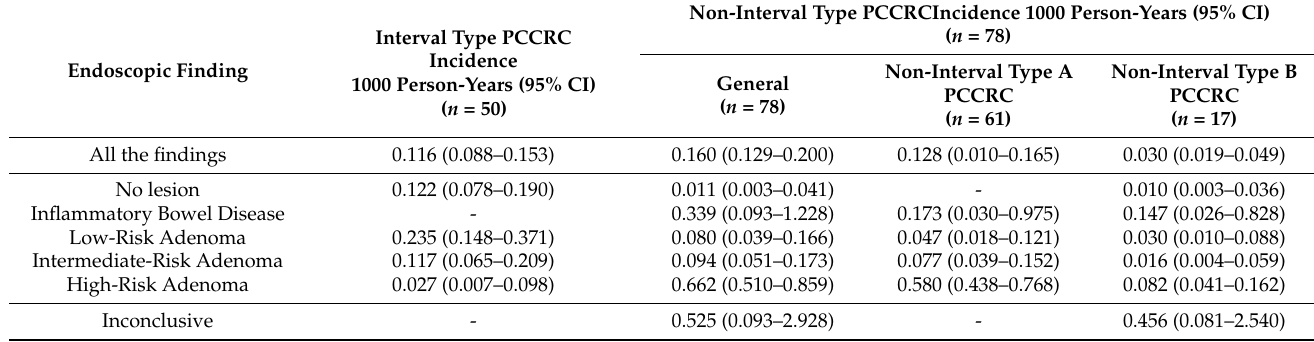
Table 1. Incidence of post-colonoscopy colorectal cancer (PCCRC) according to the type of lesion detected at index colonoscopy in the 128 interval and non-interval type PCCRCs.